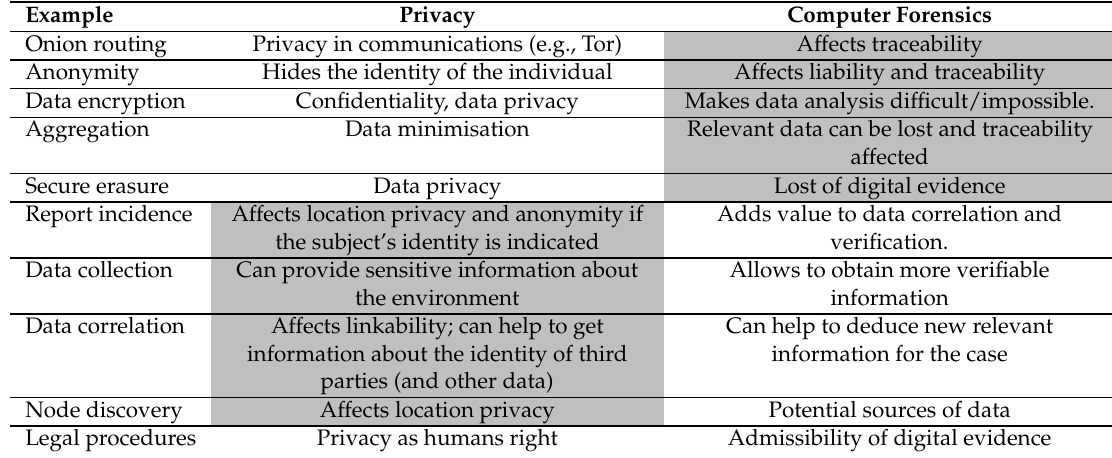
Table 3. Similarities and Conflicts between Digital Forensics and Privacy.